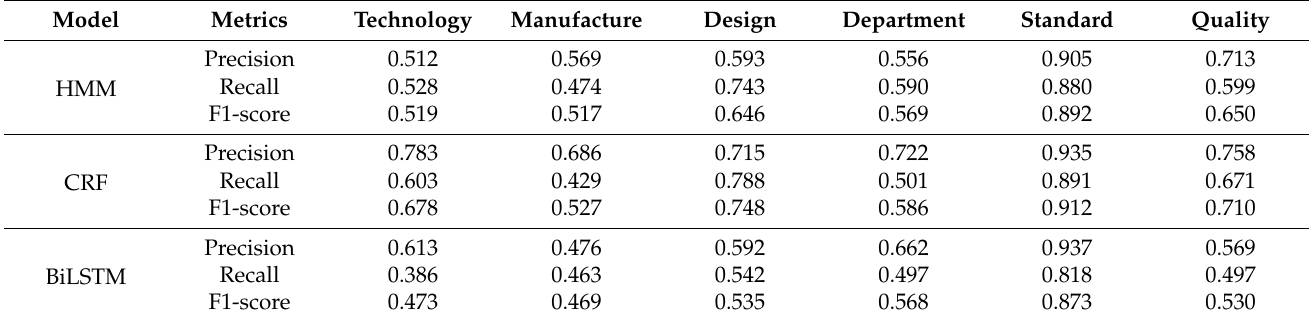
Table 2. Entity extraction model results metrics.